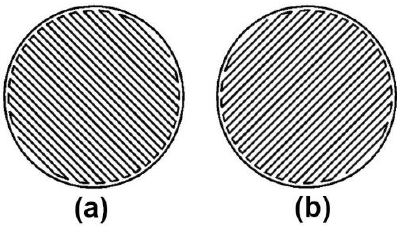
Figure 1. Tracing patterns of roof and floor layers. ( a ) roof layer; ( b ) floor layer. For the middle layers, it is worth noting that the 3D printing program for each infill pattern is inconsistent. Firstly, the triangular fill is the simplest program, which repeats the unitary tracing pattern, shown in Figure 2.